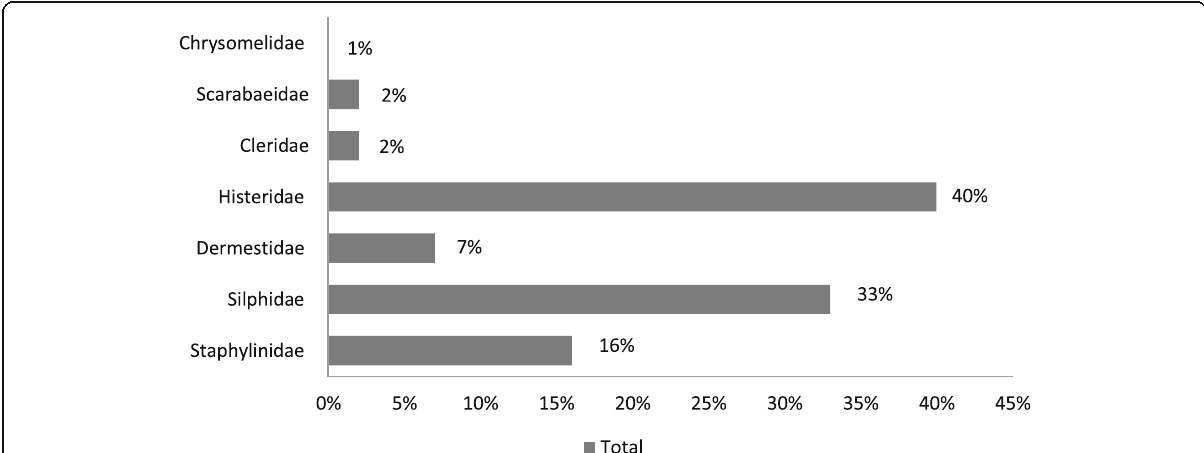
Fig. 3 Composition of Coleoptera (families) communities during decomposition. Bar chart explaining the number of specimens of seven families (%) found during the